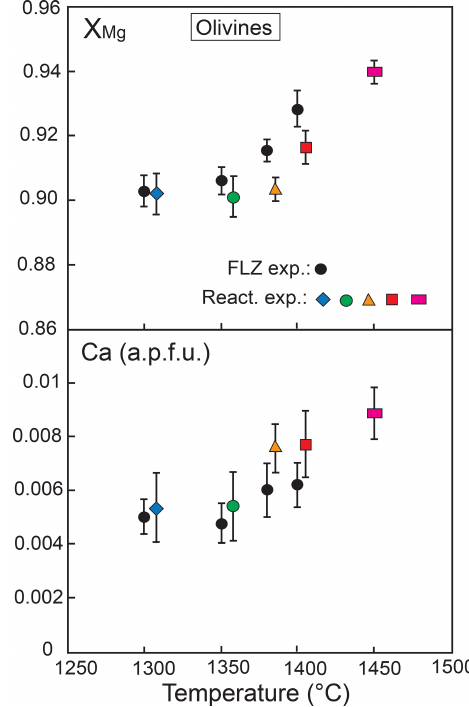
Figure 9. X Mg [ X Mg = Mg /( Mg + Fe tot ) ] and Ca content (a.p.f.u.) of olivine in the peridotite layers from reaction experiments (coloured symbols) and FLZ runs (black circles) as a function of temperature ( ◦ C) at